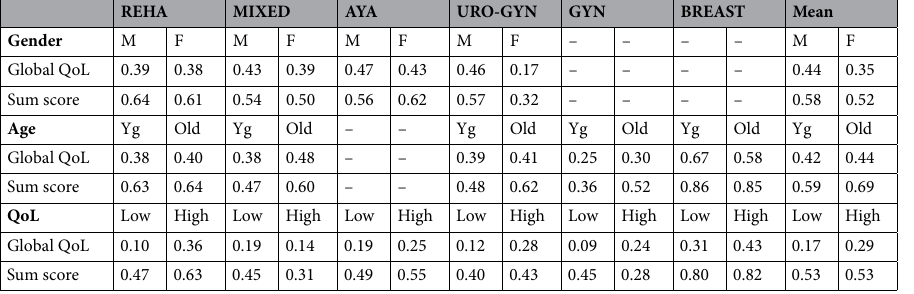
Table 4. Temporal stability (ICCs), listed by subgroups. M males, F females, Yg young (≤ median), Old (> median), Low global health/QoL ≤ median, High global health/QoL >